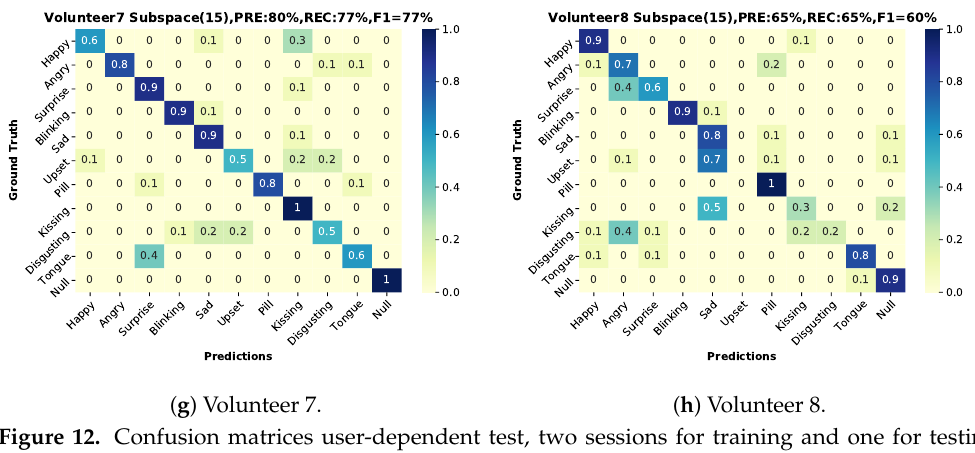
Figure 12. Confusion matrices user-dependent test, two sessions for training and one for testing with classifier, precision, recall and f1-score. ( a ) Volunteer-1 confusion matrix. ( b ) Volunteer-2 confusion matrix. ( c ) Volunteer-3 confusion matrix. ( d ) Volunteer-4 confusion matrix. ( e ) Volunteer-5 confusion matrix. ( f ) Volunteer-6 confusion matrix. ( g ) Volunteer-7 confusion matrix. ( h ) Volunteer-8 confusion matrix.